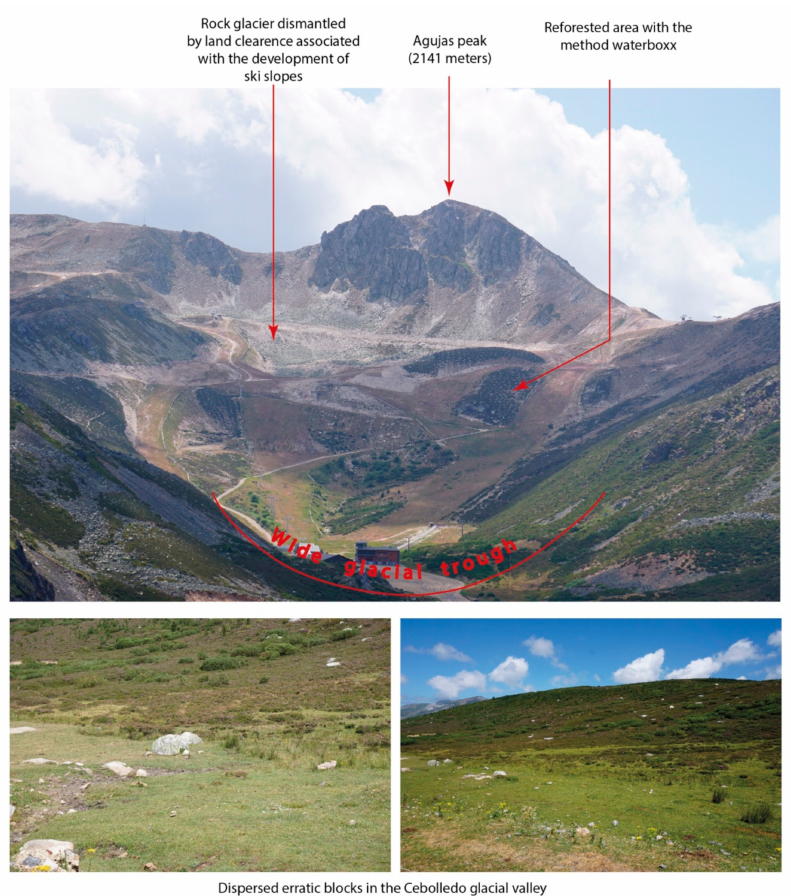
Figure 14. General panorama of the Cebolledo cirque showing the traces left by the indiscriminate opening of ski slopes and the construction of ski lifts, which led to the irreversible destruction of the pre-existing glacial morphology. The traces of the reforestation work carried out are also visible in the image. Photograph by the authors. Focus with camera on Figure through Onirix site or use the link